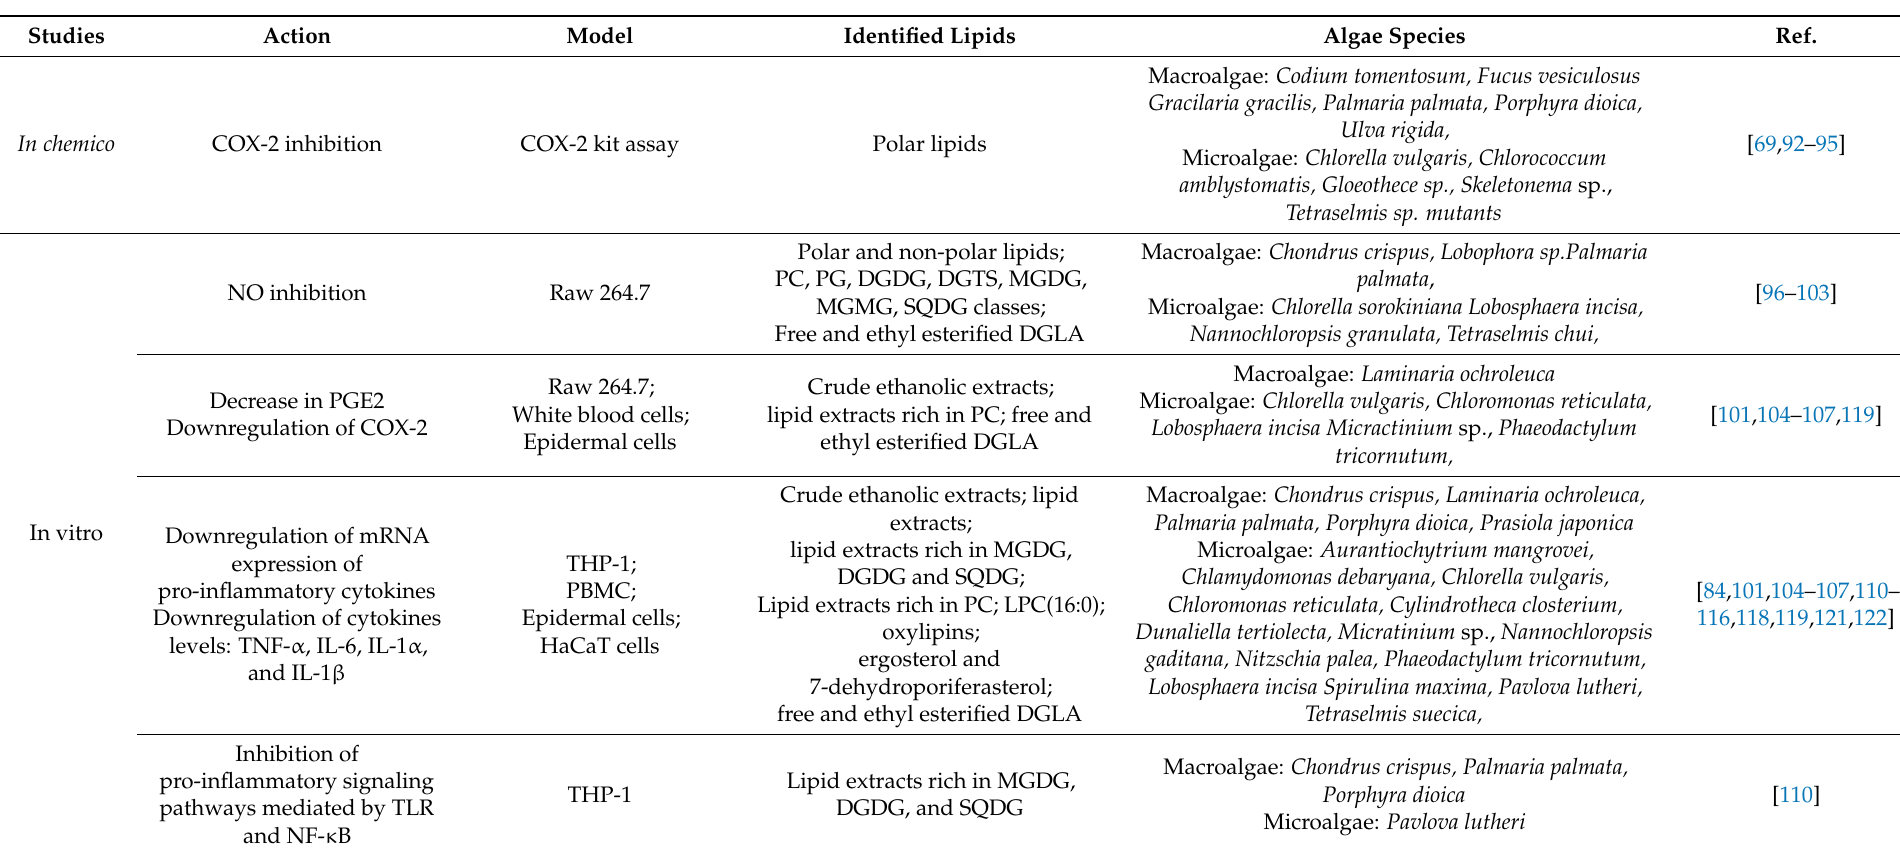
Table 2. Lipid extracts of algae with anti-inflammatory activity tested in chemico, in vitro and in vivo with a potential application on skin diseases. Abbreviation: COX-2— cyclooxygenase-2, DGDG—digalactosyldiacylglycerol, DGLA—dihomo- γ -linolenic acid, DGTS—diacylglyceryltrimethylhomoserine,